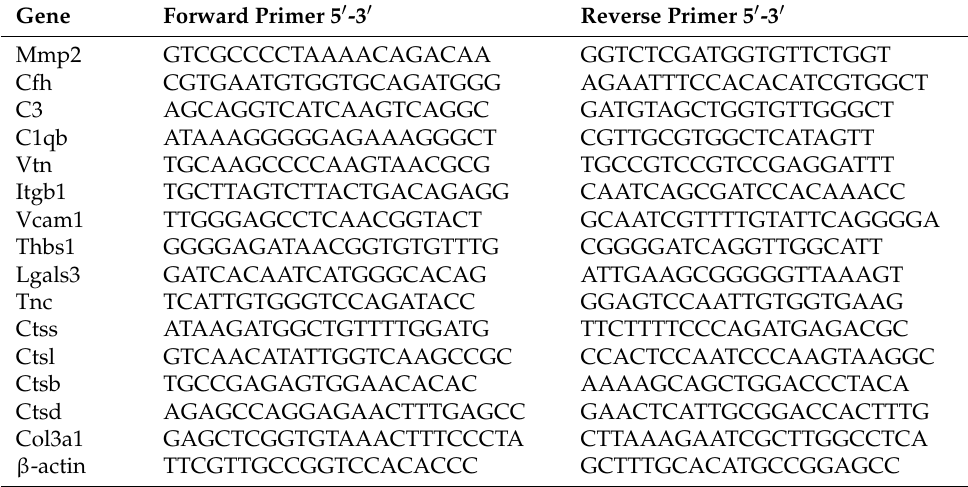
Table 2. Real-time quantitative PCR primer sequences.